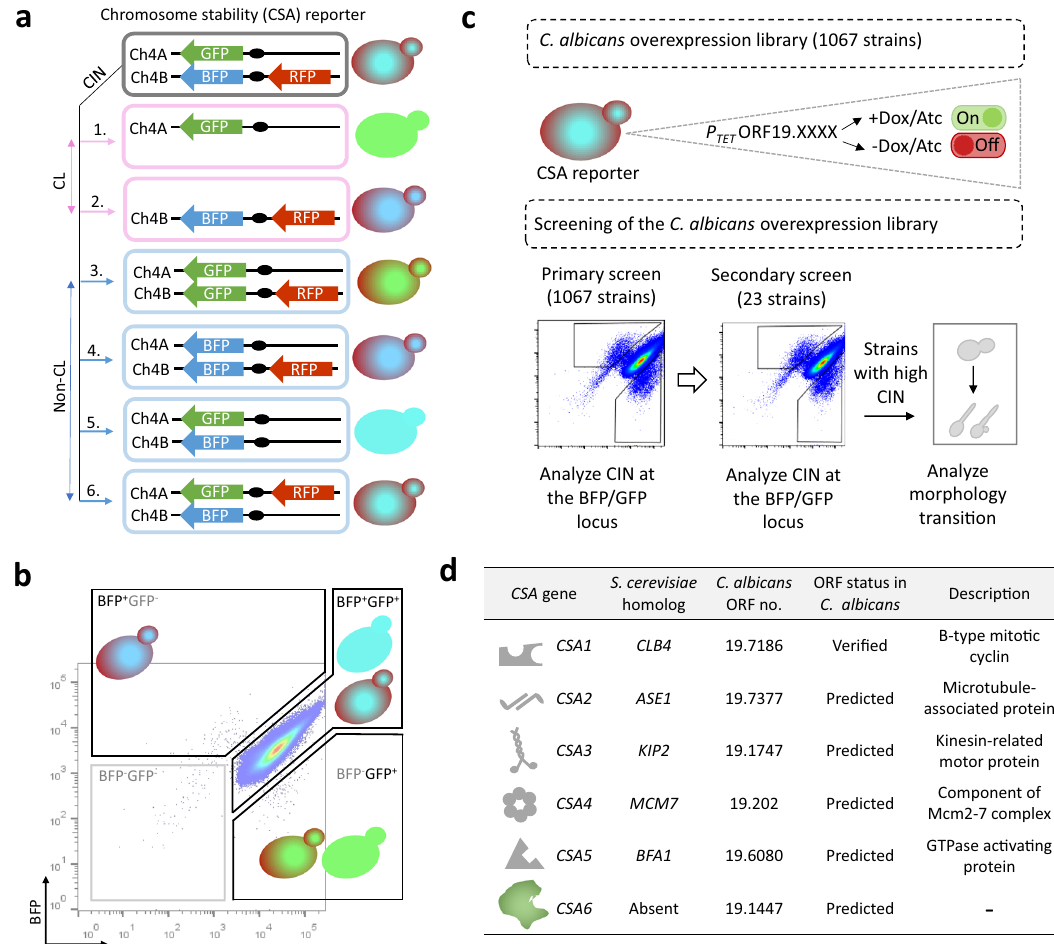
Fig. 1 A medium-throughput protein overexpression screen identi fi es a set of CSA genes in C. albicans . a Possible outcomes of CIN at the BFP/GFP and RFP loci. 1-4 , CIN at the BFP or GFP locus, because of either chromosome loss (CL) or non-CL events such as break-induced replication, gene conversion, chromosome truncation or mitotic crossing over, will lead to the expression of either GFP or BFP expressing genes. CIN due to CL can be speci fi cally identi fi ed by the concomitant loss of BFP and RFP, as shown in 1. 5 and 6 , cells undergoing non-CL events at the RFP locus will continue to express BFP and GFP. b Flow cytometric analysis of the BFP/GFP density pro fi le of empty vector (EV) (CaPJ150) containing BFP, GFP and RFP genes. The majority of